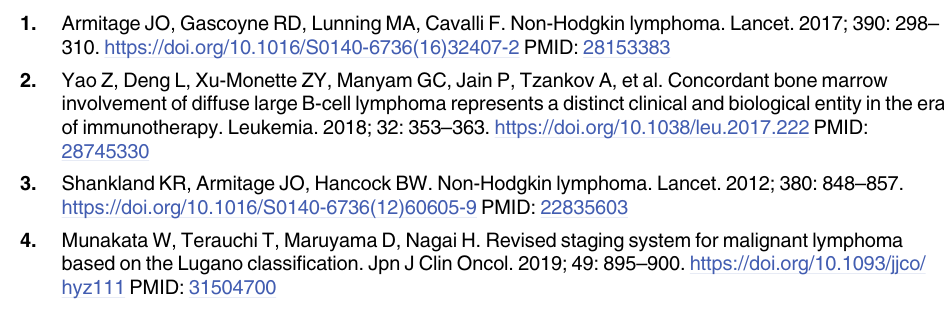
S1 Fig. Distribution of propensity scores of BMB/BMS results. S2 Fig. Distribution of propensity scores of PET/CT results. S3 Fig. Distribution of propensity scores of pelvic MRI